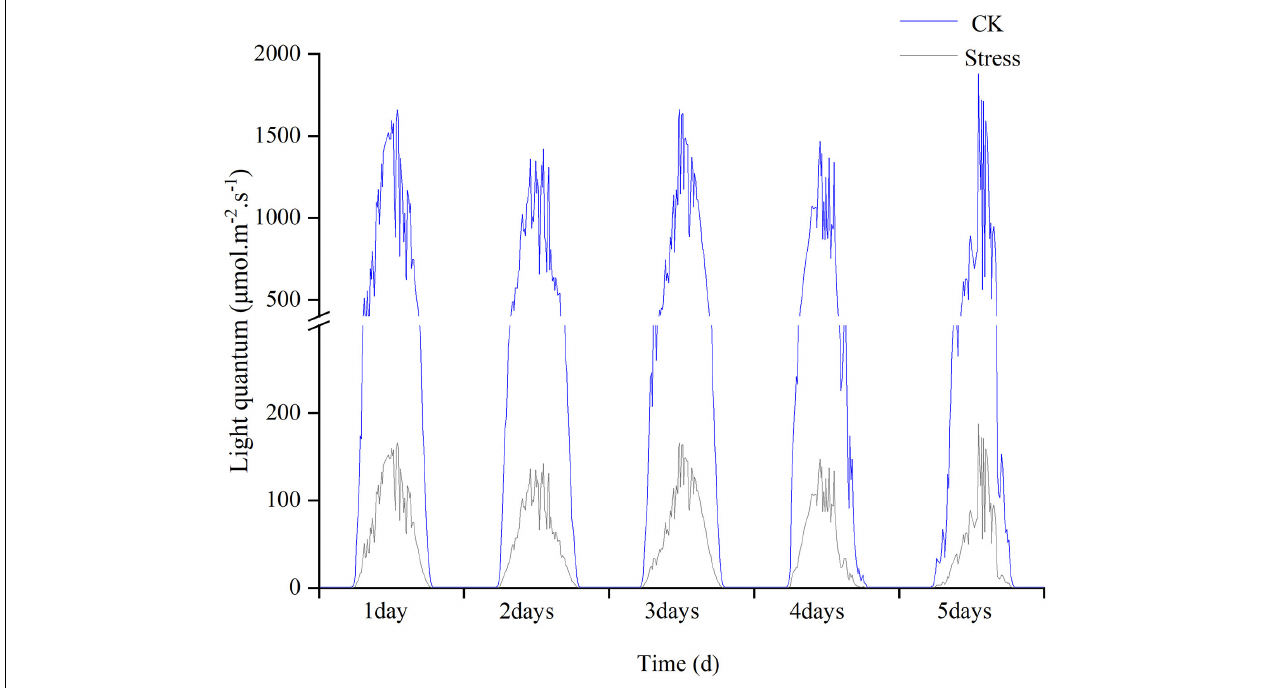
FIGURE 1 | The light intensity under control and stress conditions was monitored during the experimental period in 2017–2018.